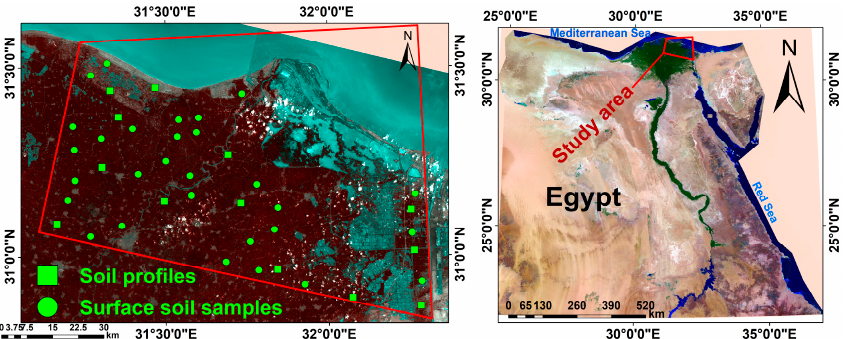
Figure 1. Geographical presentation of soil samples distribution along with the study area location.